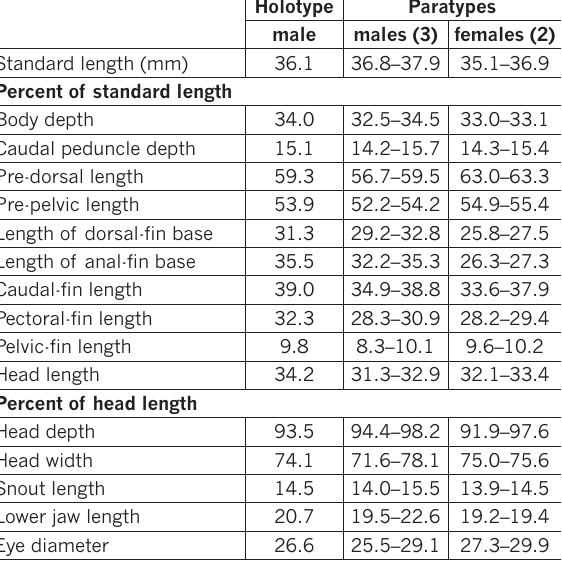
Table 1. Morphometric data of Cynolebias elegans